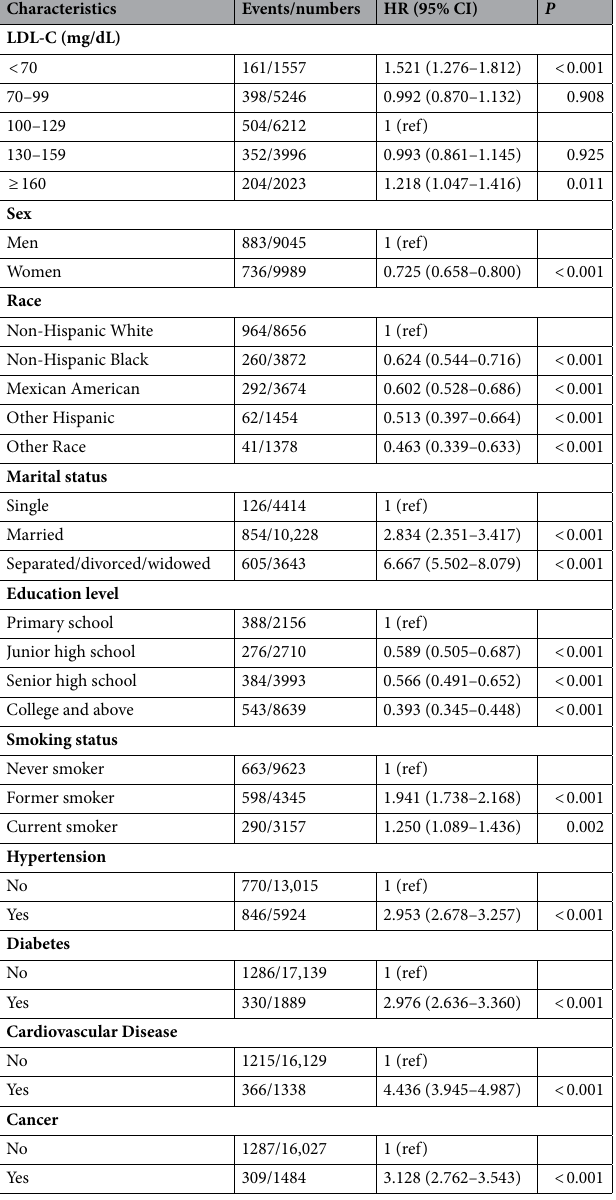
Table 2. Univariate analysis of LDL-C level and covariates associated with all-cause mortality in the NHANES Study, 1999–2014. CIs Confidence intervals, HR hazard ratio, LDL-C low-density lipoprotein